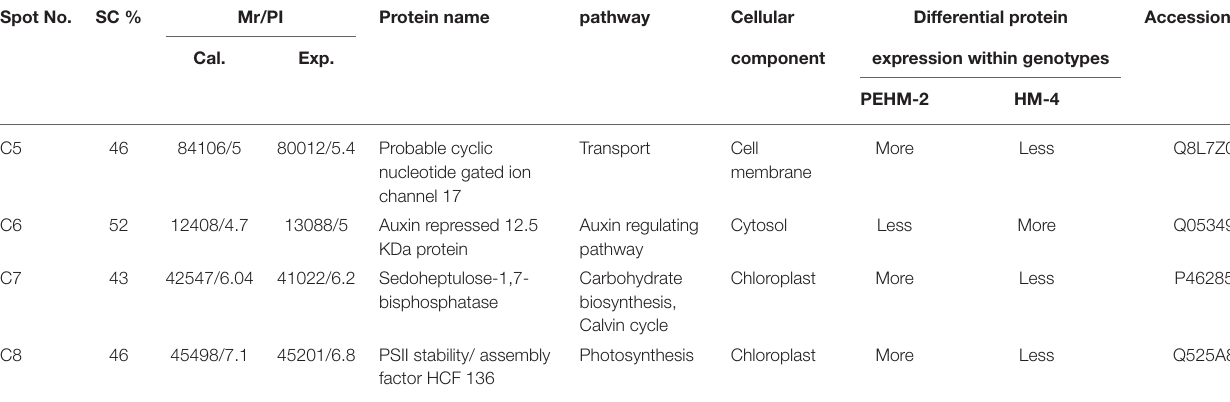
TABLE 3 | Genotypic differences in the expression of protein under controlled conditions. Spot No. SC % Mr/PI Differential protein Accession